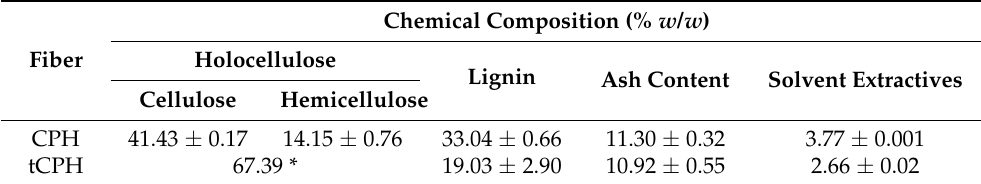
Table 3. Comparison between the chemical compositions of CPH and